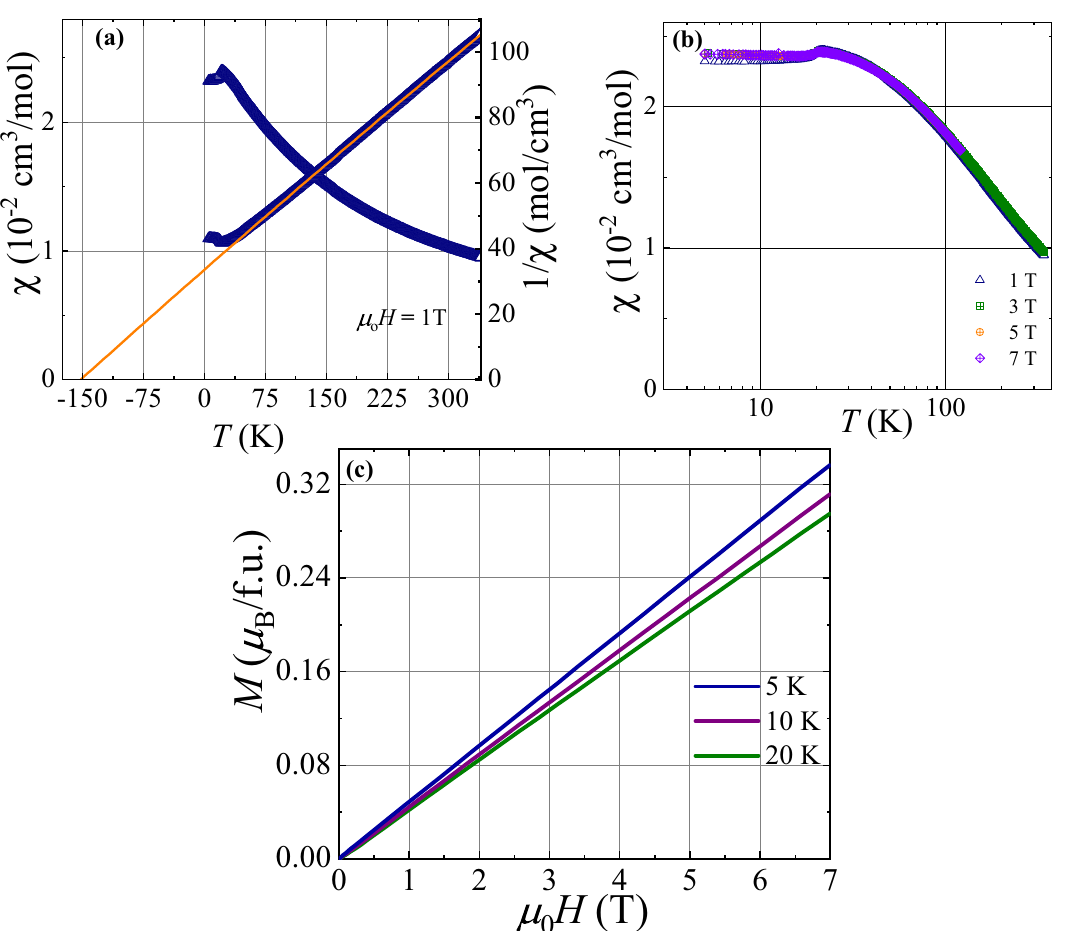
Figure 2. ( a ) The temperature dependence of dc magnetic susceptibility ( χ( T ) ; left axis) and inverse magnetic susceptibility (1/ χ( T ) ; right axis ) with the Curie–Weiss fit. ( b ) The temperature dependence of χ( T ) for different magnetic fields in the temperature range 5 K